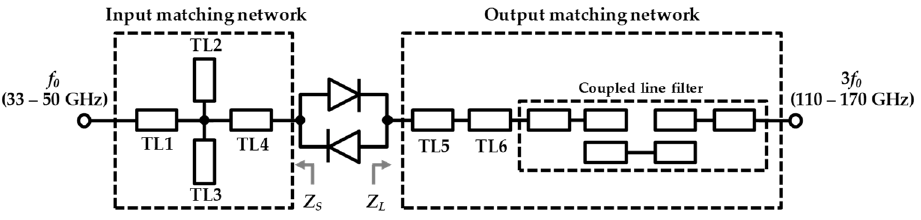
Figure 5. Schematic of designed frequency tripler.